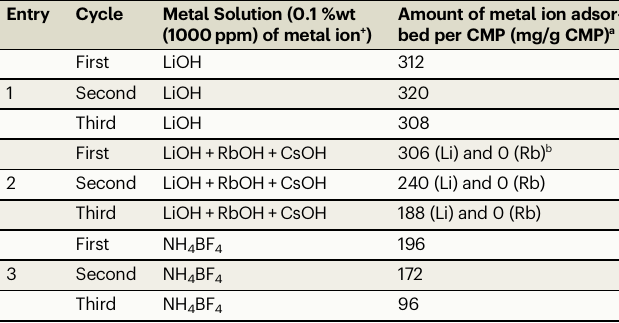
Table 3 | Adsorption of metal ions by PPDA-CMP-1 in three cycles Entry Cycle Metal Solution (0.1 %wt Amount of metal ion adsor- (1000ppm) of metal ion + ) bed per CMP (mg/g CMP) a